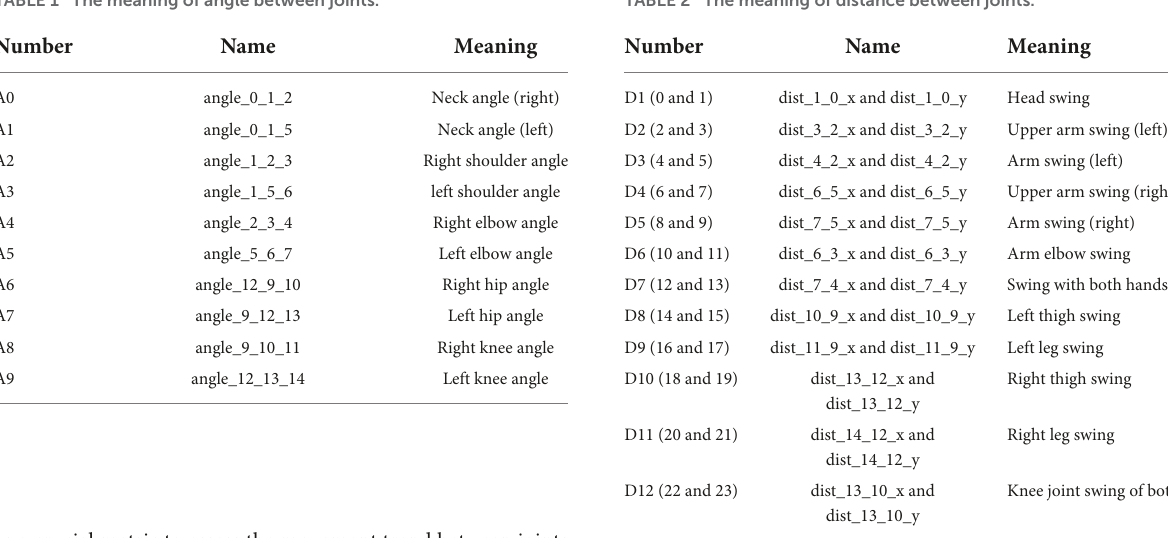
TABLE 1 The meaning of angle between joints. TABLE 2 The meaning of distance between joints.